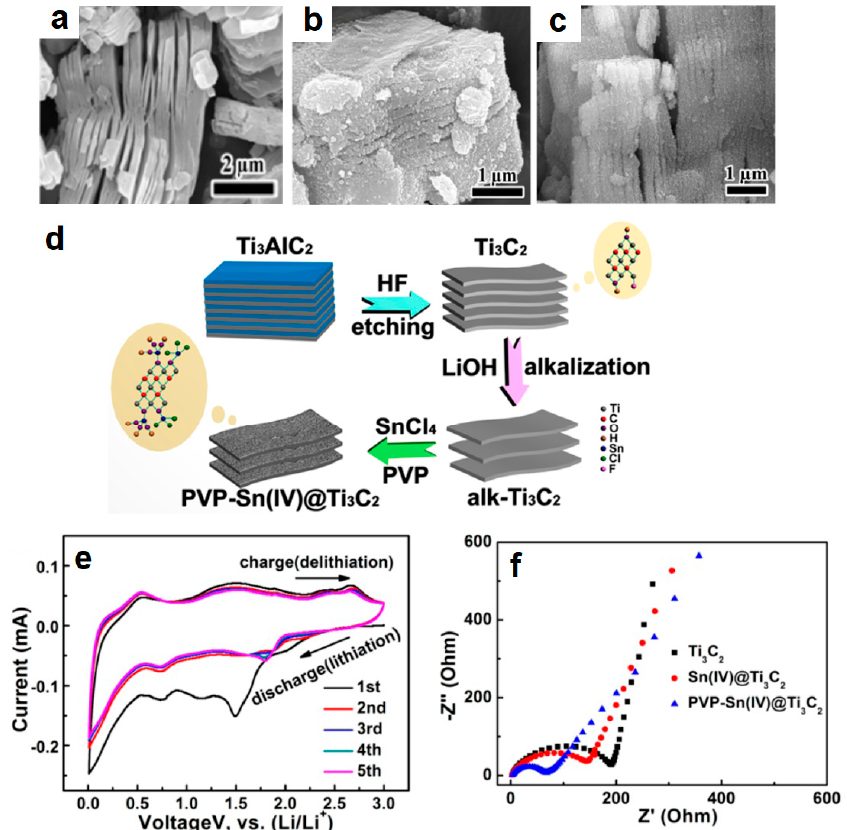
Figure 6. ( a ) SEM image of Ti 3 C 2 nanosheets; ( b ) SEM image of Sn(IV)@Ti 3 C 2 composites; ( c ) SEM image of PVP − Sn(IV)@Ti 3 C 2 nanocomposites; ( d ) Schematic illustration of the polyvinylpyrrolidone (PVP) − assisted liquid-phase immersion process to produce PVP − Sn(IV)@Ti 3 C 2 nanocomposites; ( e ) CV curves of PVP − Sn(IV)@Ti 3 C 2 nanocomposites; ( f ) Nyquist plots at 100 kHz to 10 mHz of the Ti 3 C 2 , Sn(IV)@Ti 3 C 2 , and PVP-Sn(IV)@Ti 3 C 2 electrodes. Reprinted with permission from [50] . Copy-